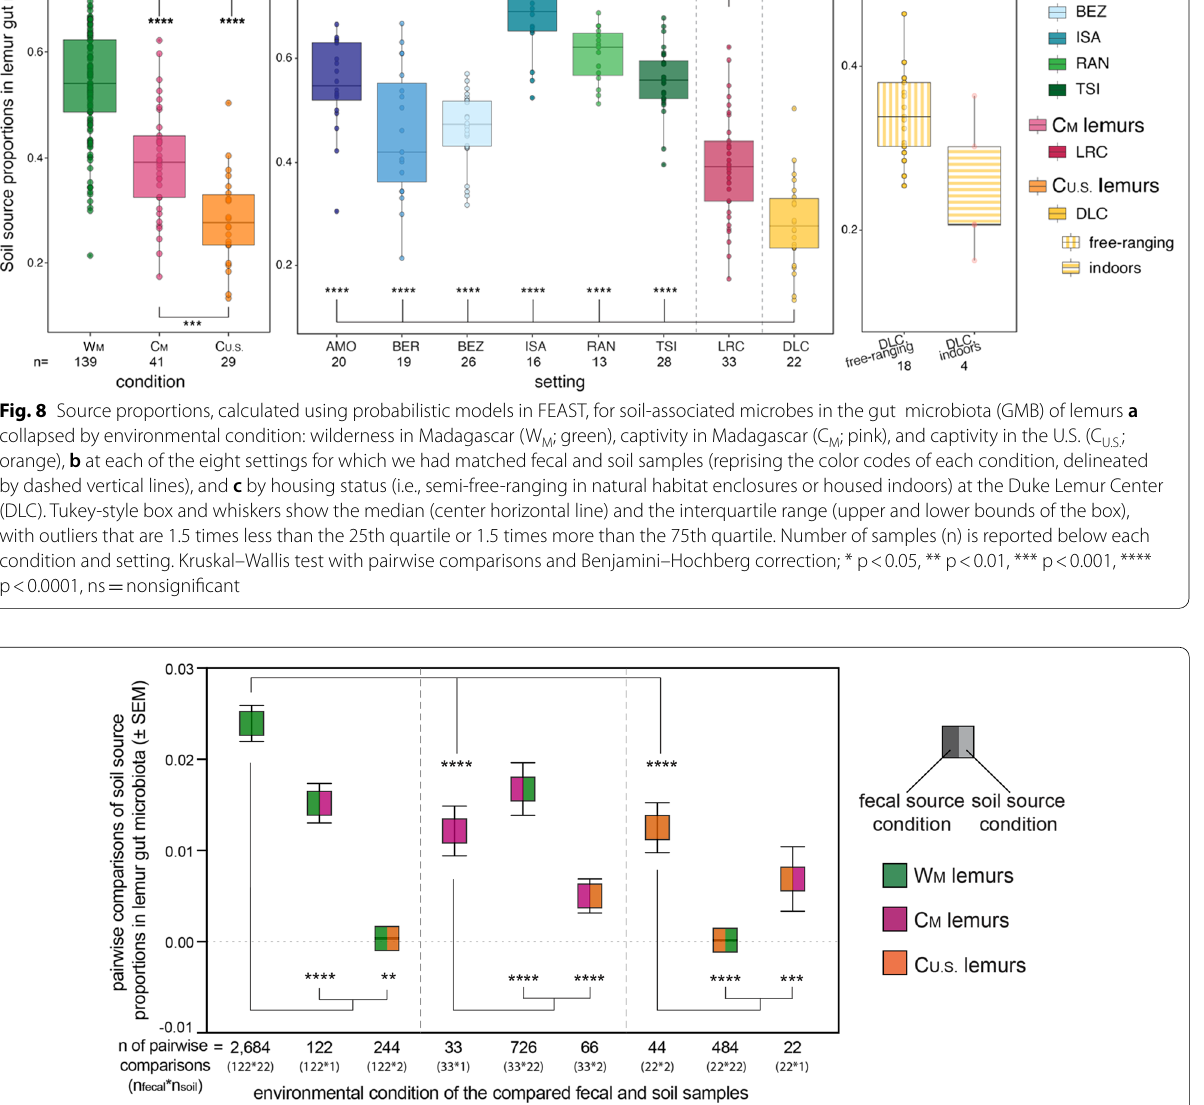
Fig. 9 Source proportions, calculated using probabilistic models in FEAST, for soil-associated microbes in the gut microbiota of lemurs within (single color) and between (two colors) the three environmental conditions that encompass eight settings: wilderness in Madagascar (W M ; green), captivity in Madagascar (C M ; pink), and captivity in the U.S. (C U.S. ; orange). Within the gut microbiota of lemurs from a given environmental condition (left color fecal source condition), values show the proportion of soil associated microbes from a given condition (right color soil = = source condition). The center of the box reflects the mean and the error bars represent the standard error of the mean (SEM). Number of pairwise ± comparisons and the associated calculation is reported below each box. Kruskal–Wallis test with pairwise comparisons and Benjamini–Hochberg correction; ** p < 0.01, *** p < 0.001, **** p <